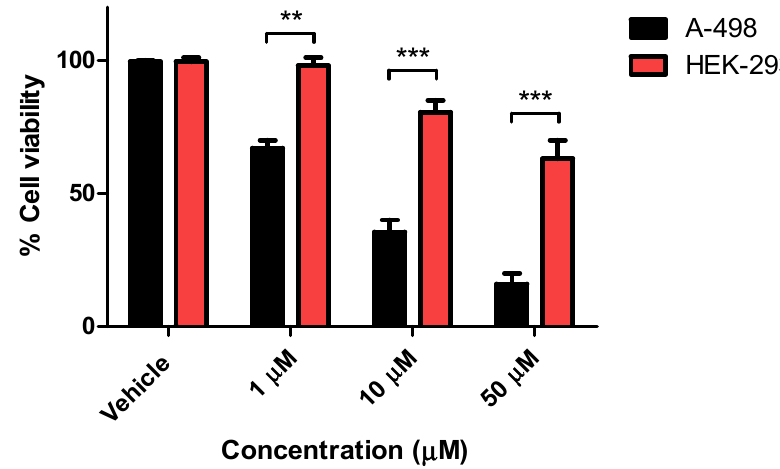
Figure 3. Antiproliferative activity of compound 9c in tumorigenic A-498 cells and non-tumorigenic HEK-293 cells. The experiment was performed in triplicate and significance was represented as mean ± S.D. ** = p < 0.01; *** = p < 0.001 between indicated